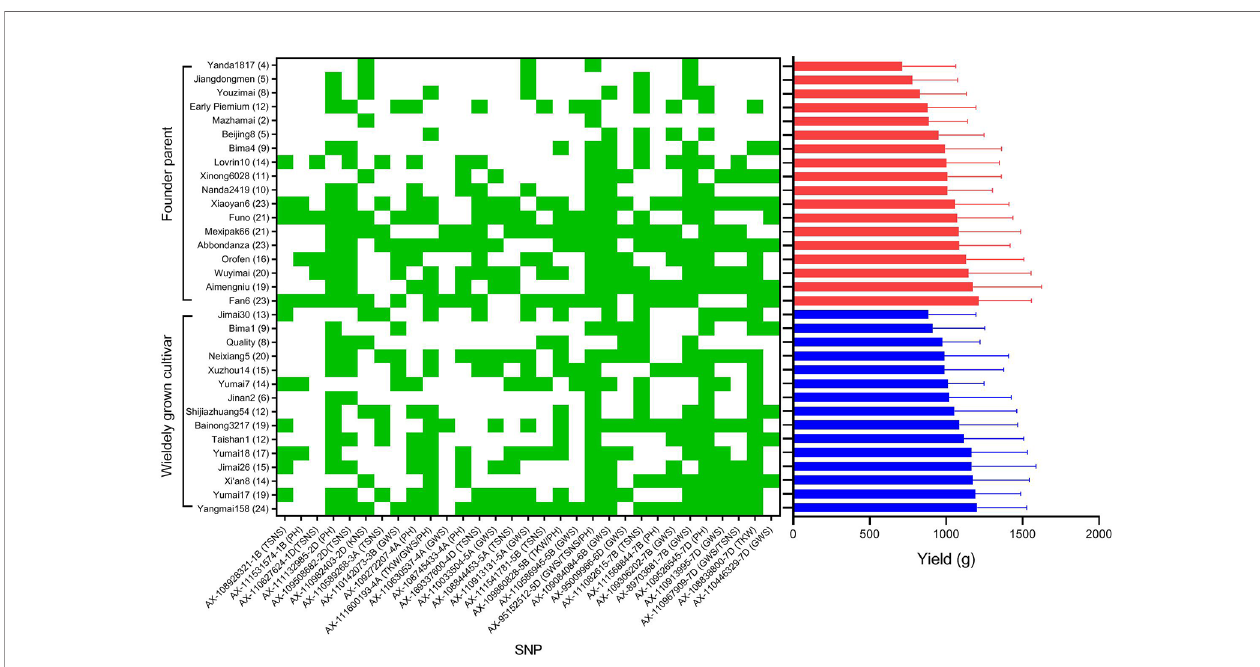
FIGURE 7 | The distribution of superior alleles in widely grown cultivars and founder parents and the variation of yield. Green indicates the distribution of favorable alleles, red and blue histogram represent the mean yield of 18 founder parents and 15 widely grown cultivars, respectively. The number of favorable alleles for each cultivar is in parentheses.